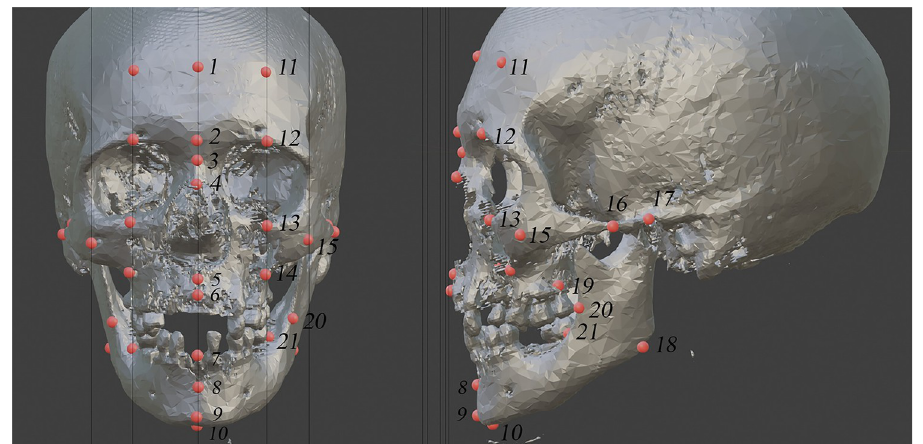
Fig 1. Craniometric landmarks